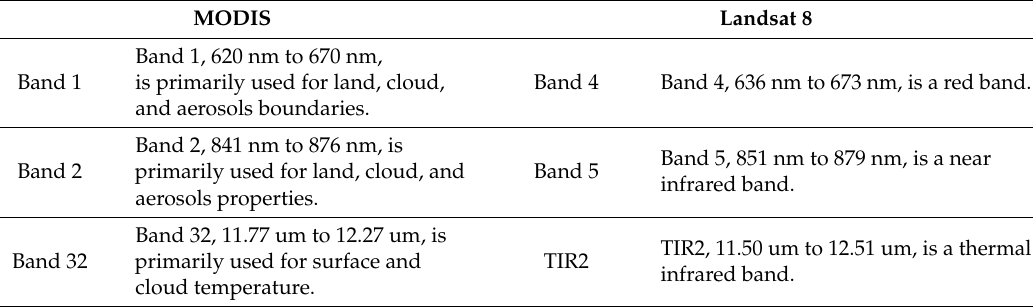
Table 2. Moderate Resolution Imaging Spectroradiometer (MODIS) (1000 m) and Land Remote